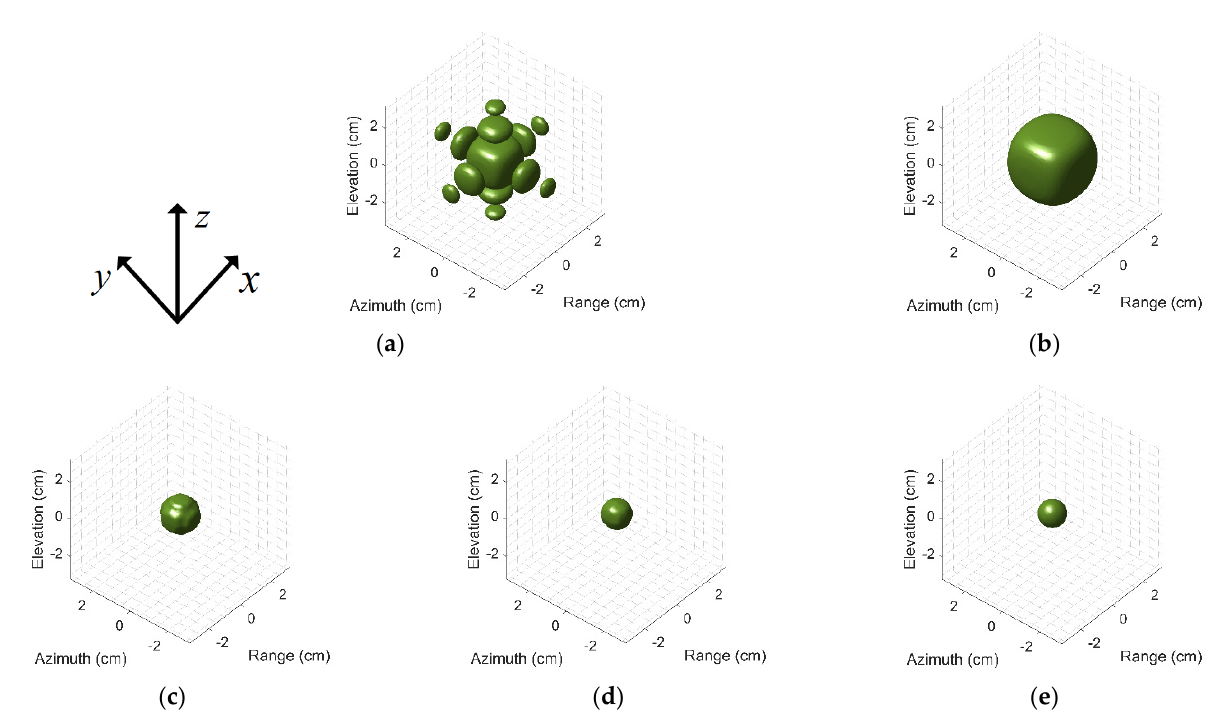
Figure 5. Three-dimensional images of point target ( 0,0,0 ) by ( a ) 3D IFFT without windowing, ( b ) 3D IFFT with windowing, ( c ) BPDN, ( d ) SR-CNN, ( e ) Ground-truth.